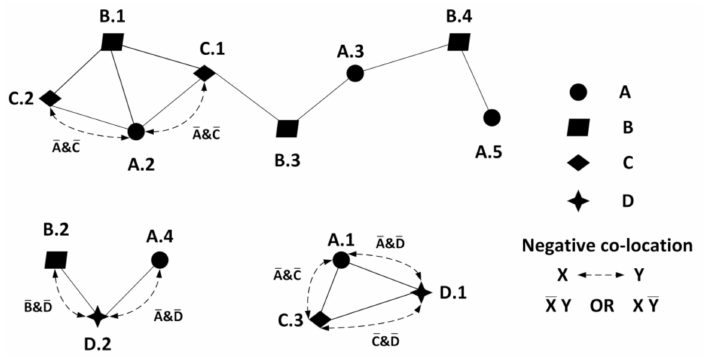
Figure 1. Spatial negative co-location